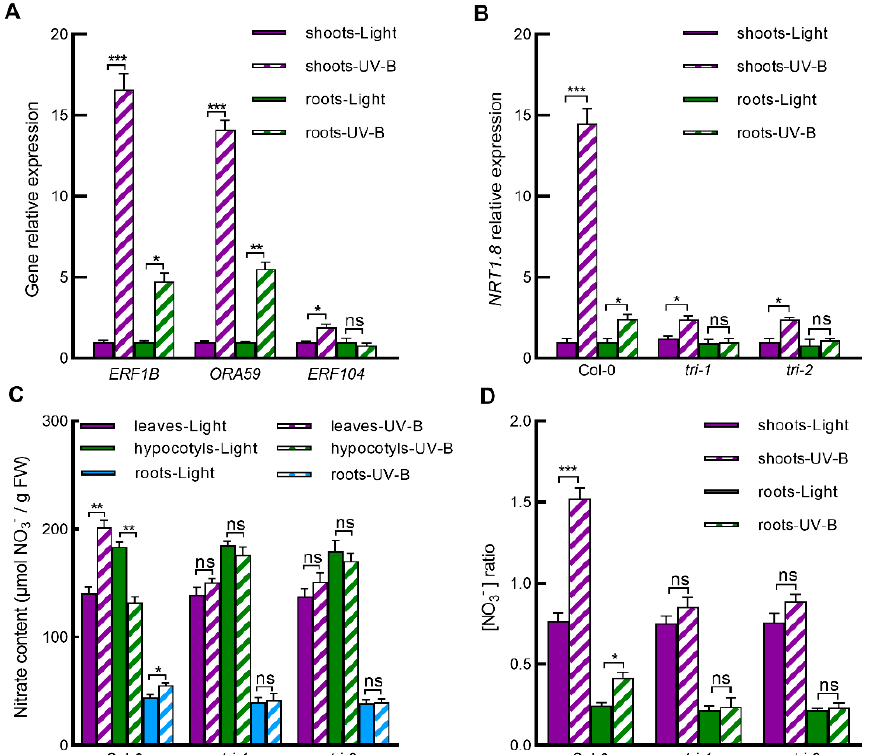
Figure 3. UV-B induced expression of ERF genes, and ERFs mediated UV-B-induced NRT1.8 expression and nitrate reallocation to leaves and roots. ( A , B ) Expression of ERF1B , ORA59 , and ERF104 in shoots and roots of wild-type Col-0 ( A ) and expression of NRT1.8 in shoots and roots of wild-type Col-0 and the ora59 erf104 erf1b triple mutants tri-1 and tri-2 ( B ) were determined by qPCR in plants exposed to light alone (Light) or with 0.5 W/m 2 UV-B (UV-B) for 3 h. Data are presented as values relative to those under light treatments after normalization to those of ACTIN2 . ( C , D ) Nitrate concentration was determined in leaves, hypocotyls and roots of wild-type Col-0, tri-1 and tri-2 plants exposed to light alone (Light) or with UV-B (UV-B) for 3 h ( C ), and then leaf/hypocotyl (L/H) and root/hypocotyl (R/H) nitrate ratios were calculated ( D ). Values are means ± SE ( n = 3). Data with asterisks indicate significant differences between light and UV-B treatments (* p < 0.05; ** p < 0.01; *** p < 0.005; ns: no significant difference).